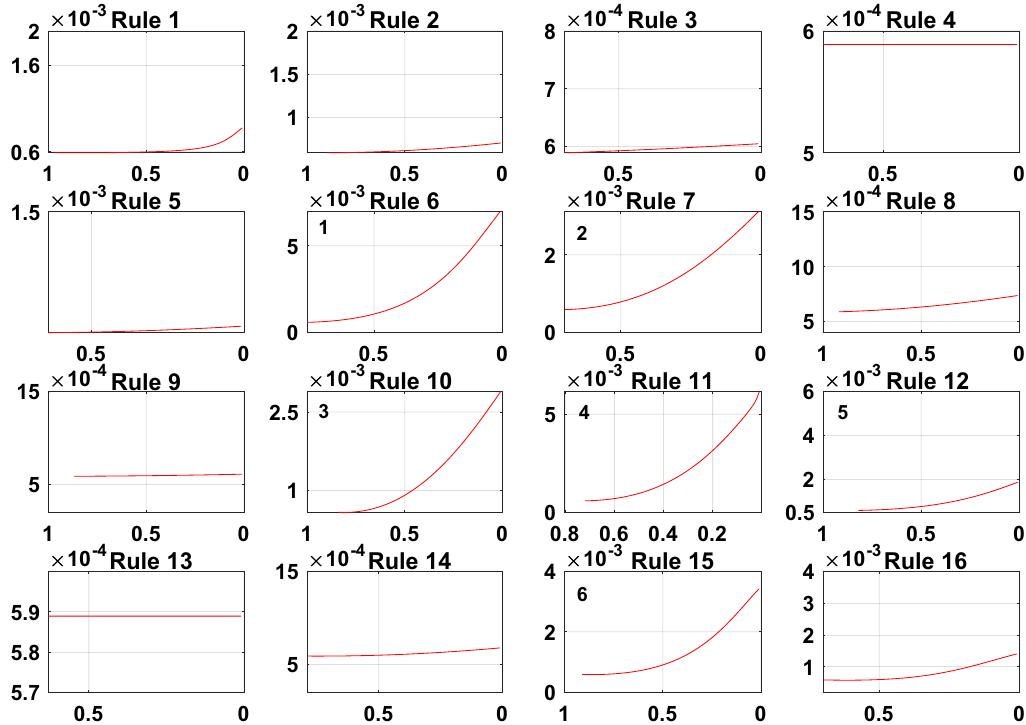
Figure 16. The sensitivity analysis of trained Sub-BRB2 (x-axis represents rule weights, y-axis represents MSE).